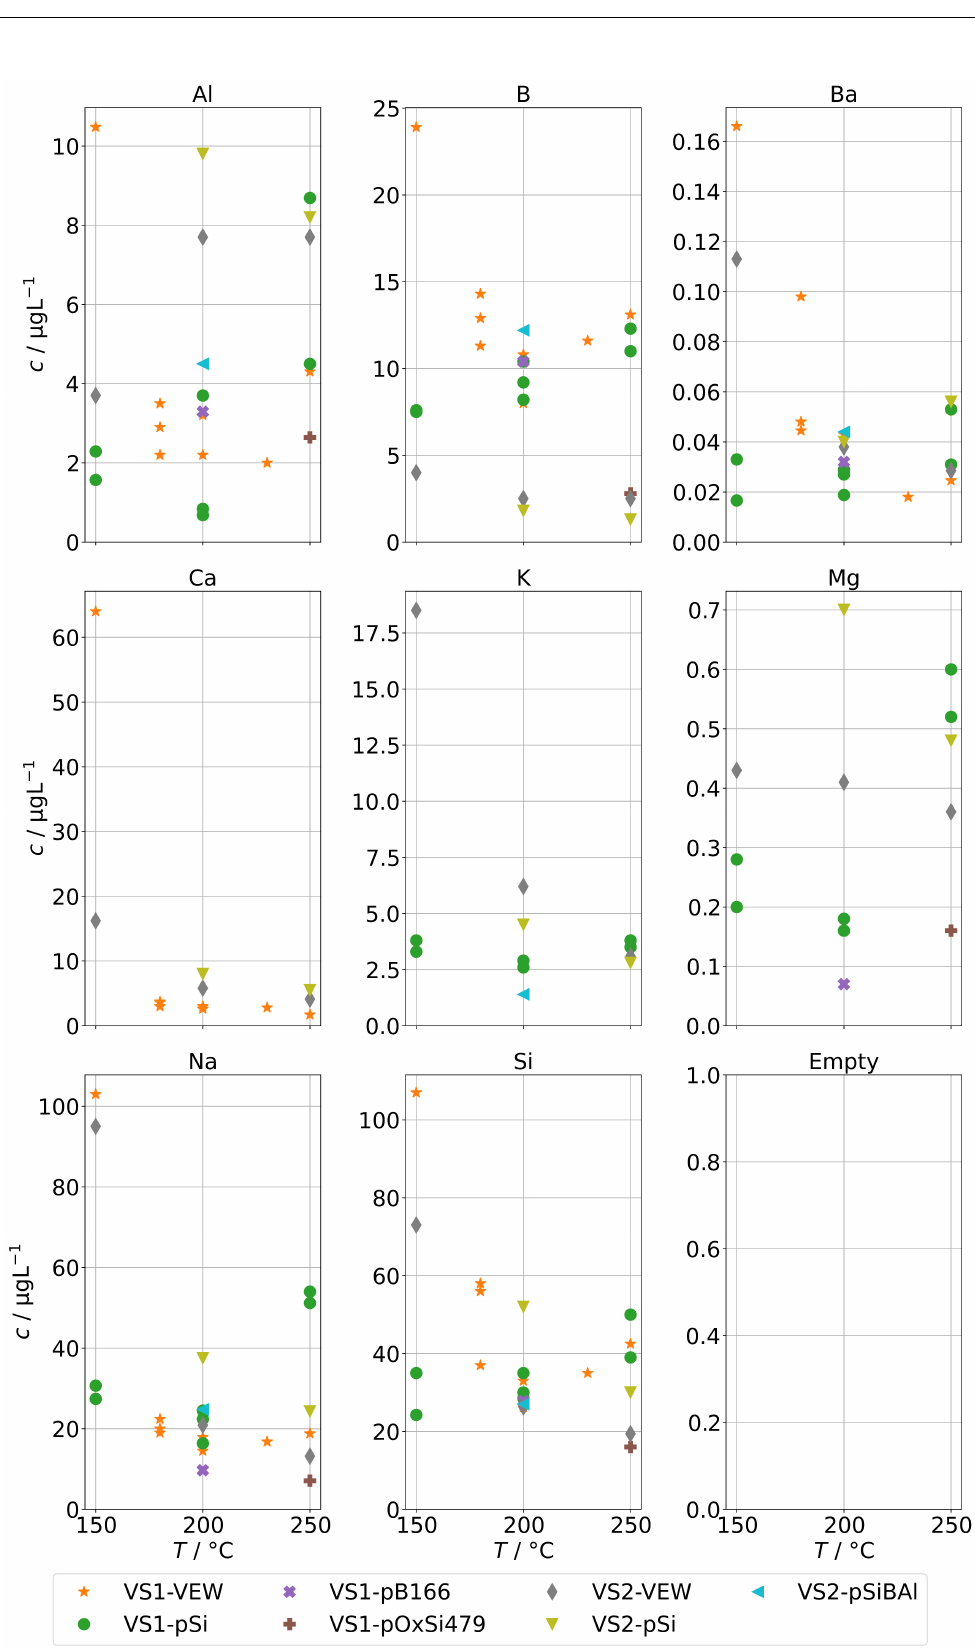
Figure 7. Background concentrations of quantifiable species in condensates of the SB-SG (group B) in dependence of operation